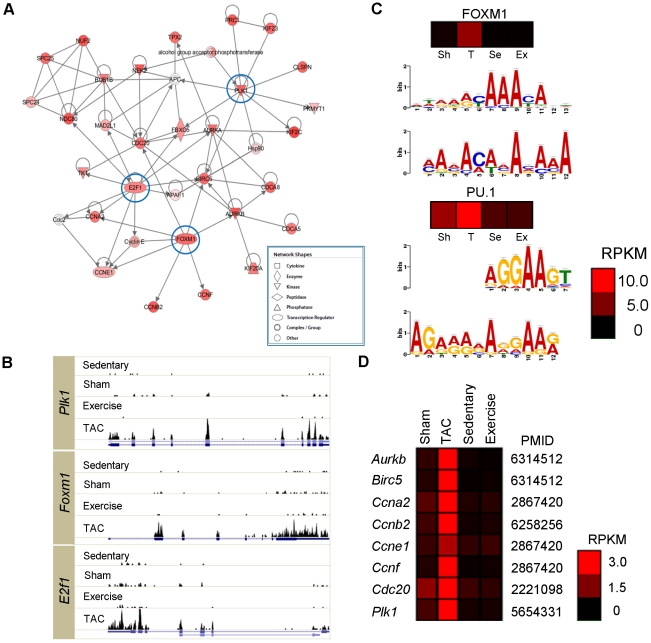
Network of the genes turned on in PAH.(A) Top-scoring network derived from the 417 genes dramatically increased in PAH, despite their extremely low expression (<2 RPKM) in either normal adult heart or exercise-trained heart. The red-colored nodes represent up-regulated genes. (B) The histograms for the reads that were mapped by the UCSC isoforms of Plk1, Foxm1 and E2f1 in the different animal models. The blue lines underneath represent UCSC gene structures and the boxes show the exons of the genes. Expression of the 3 genes is only dominant in TAC. (C) The predicted motifs enriched in 1,000 bp upstream of 417 genes. The motifs shown on the bottom were predicted by MEME and the motifs shown above are the consensus motifs for the TFs (FOXM1 and PU.1). Y-axis indicates the amount of information at each position in the motif. The heatmaps (unit: RPKM) show the expression levels of the predicted TFs in sham (Sh), TAC (T), Se (Sedentary) and E (exercise). (D) Degree of expression (unit: RPKM) of the known targets of FOXM1 in the animal models are shown along with the previous evidence (PMID).